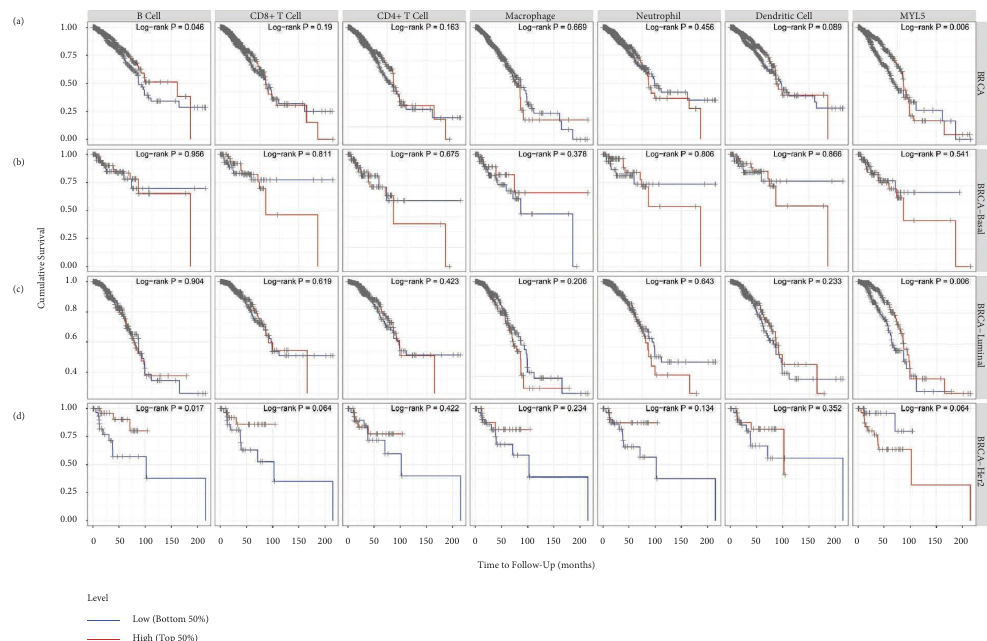
Figure 6: Prognostic analysis of MYL5 expression and immune infltrate cells among diferent molecular subtypes of BRCA. We used the TIMER tool to analyze the correlation of MYL5 with B cell, M1 macrophage, M2 macrophage, tumor-associated macrophage (TAM), monocytes, and T cell exhaustion among BRCA (a), BRCA-Basal (b), BRCA-luminal (c), and BRCA-Her2